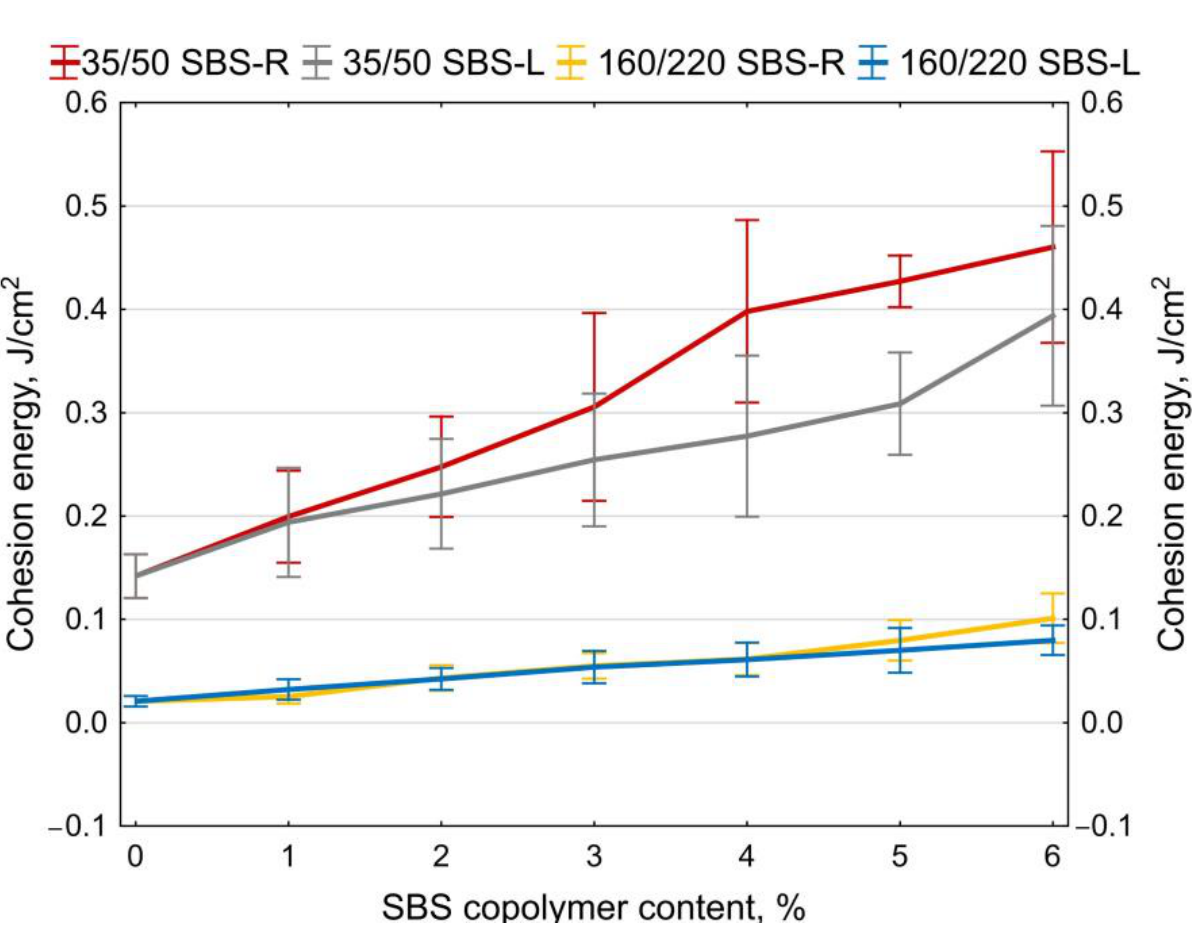
Figure 17. Cohesion energy of bitumen during stretching in Area I (as per Figure 2b), error bars show a 95% confidence interval for the